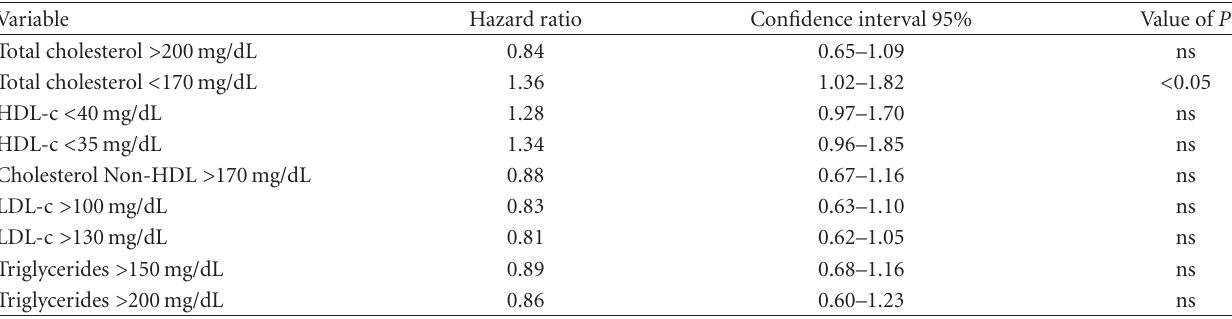
Table 3: All-cause mortality risk and lipid levels in adjusted by sex, age > 75, hypertension, and diabetes (excluded body mass index < 20kg/m 2 and early mortality < 2